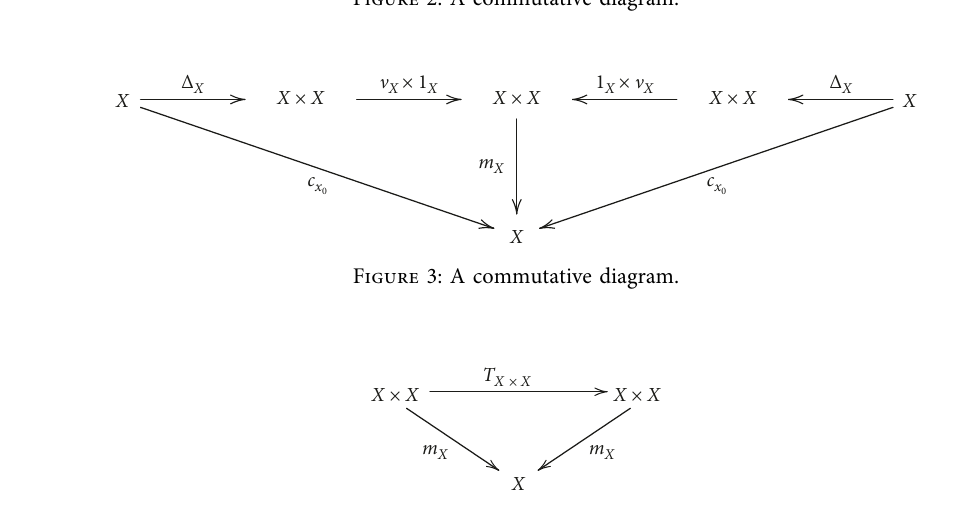
Figure 2: A commutative diagram.